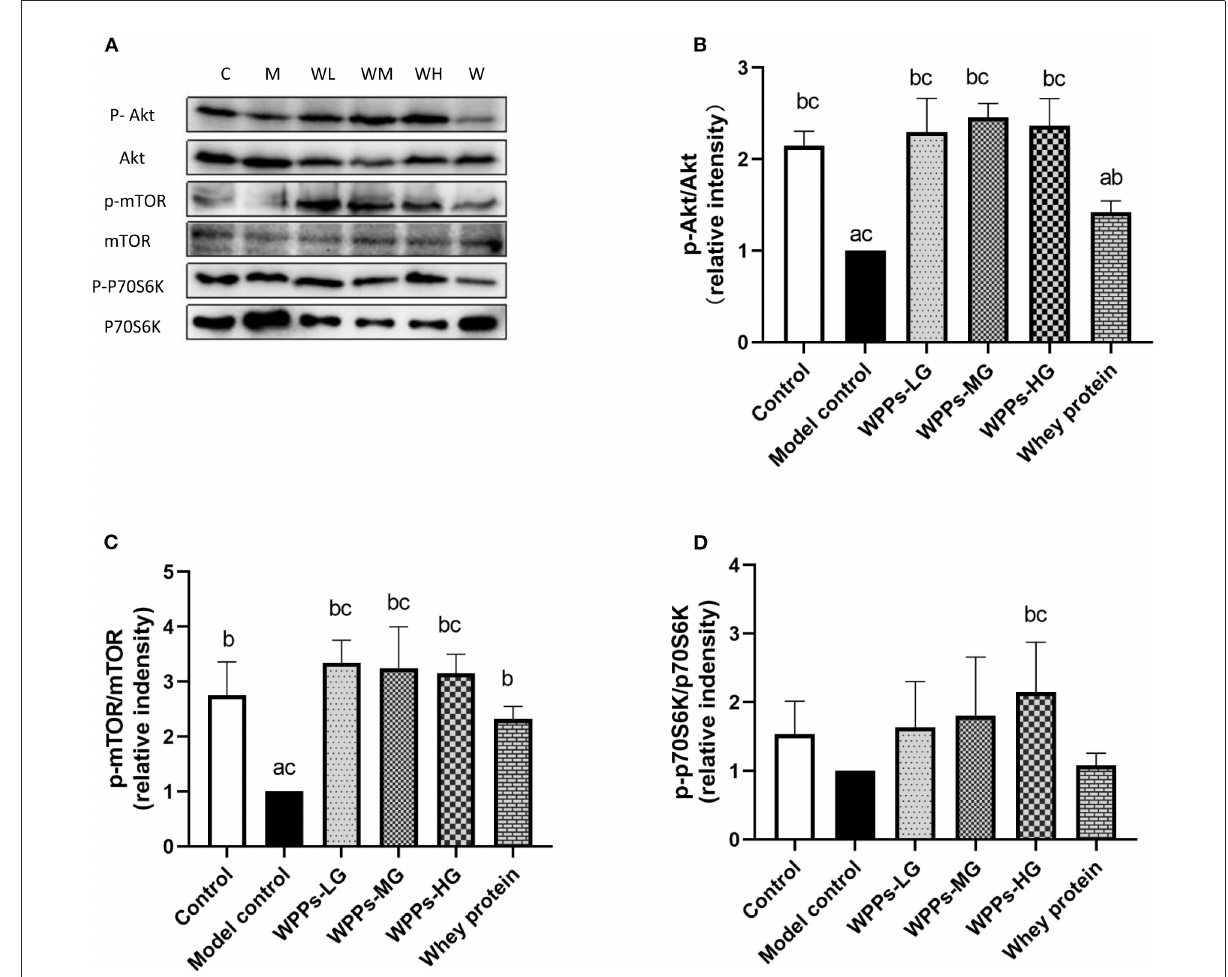
FIGURE6 Regulation of mTOR signaling by WPPs in elder mice. Related proteins were analyzed by Western blot (A) . Effects of WPPs on Phosphorylation of Akt /Akt in the GAS of mice (B) . Effects of WPPs on Phosphorylation of mTOR / mTOR in the GAS of mice (C) . Effects of WPPs on Phosphorylation of p70S6K / p70S6K in the GAS of mice (D) . Results are expressed as mean ± SD (n = 3). a p < 0.05 indicates significant difference vs. the control group; b p < 0.05 indicates significant difference vs. the model group. Whey protein group at a dose of 1.5